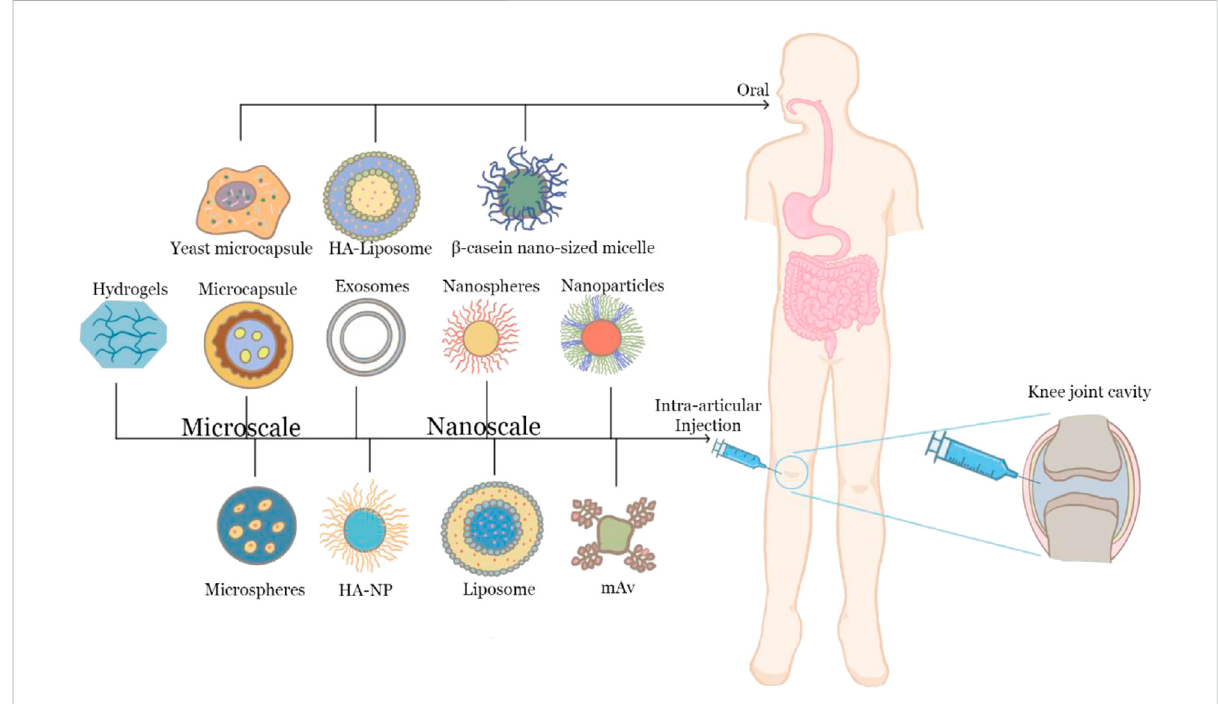
FIGURE 3 Oral delivery and intra-articular injection systems for